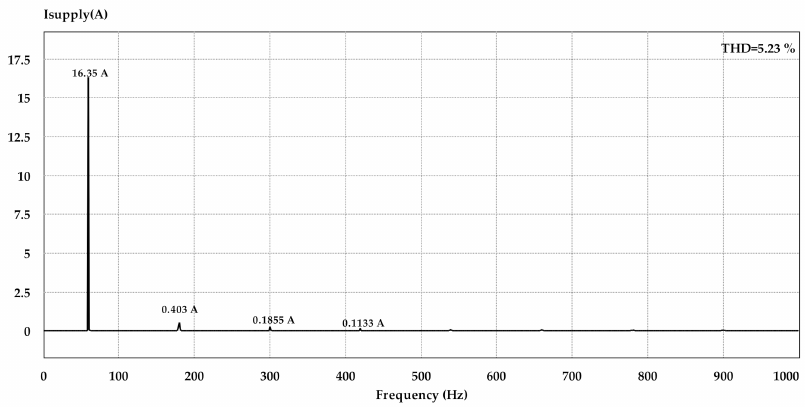
Figure 31. Frequency spectrum of the supply current at full load with the proposed IP current